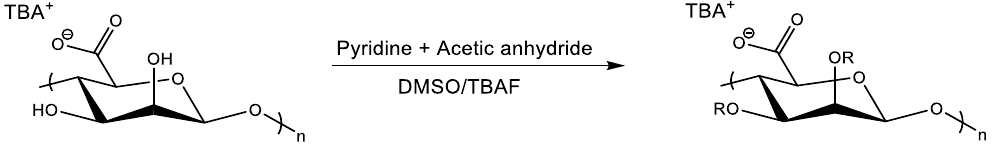
Figure 5. Alginate esterification of TBA alginate using alkyl halides [42] .